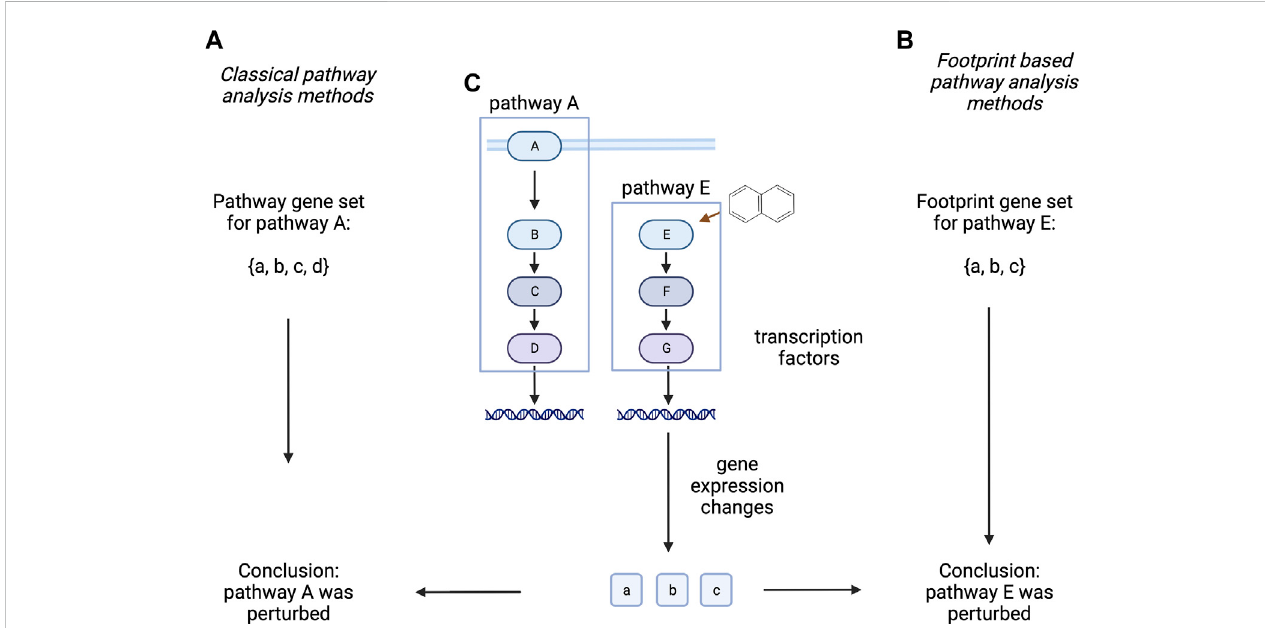
FIGURE 3 Classical and footprint based pathway analysis methods. Classical pathway analysis methods (A) use the gene set created from pathway member genes. Footprintbasedpathwayanalysismethods (B) usegenesetsofpathwayregulatedgenes.Inahypotheticalexperiment (C) ,whereproteinEisperturbedwitha drug,alteredexpressionofa,b,cgenesismeasured.ClassicalmethodsinferthealteredactivityofPathwayA(composedofA,B,C,Dproteins),whilefootprint based methods correctly identify Pathway E as the target of the perturbation. Proteins are labelled with uppercase while corresponding mRNA with lowercase letters. Created with BioRender.com.